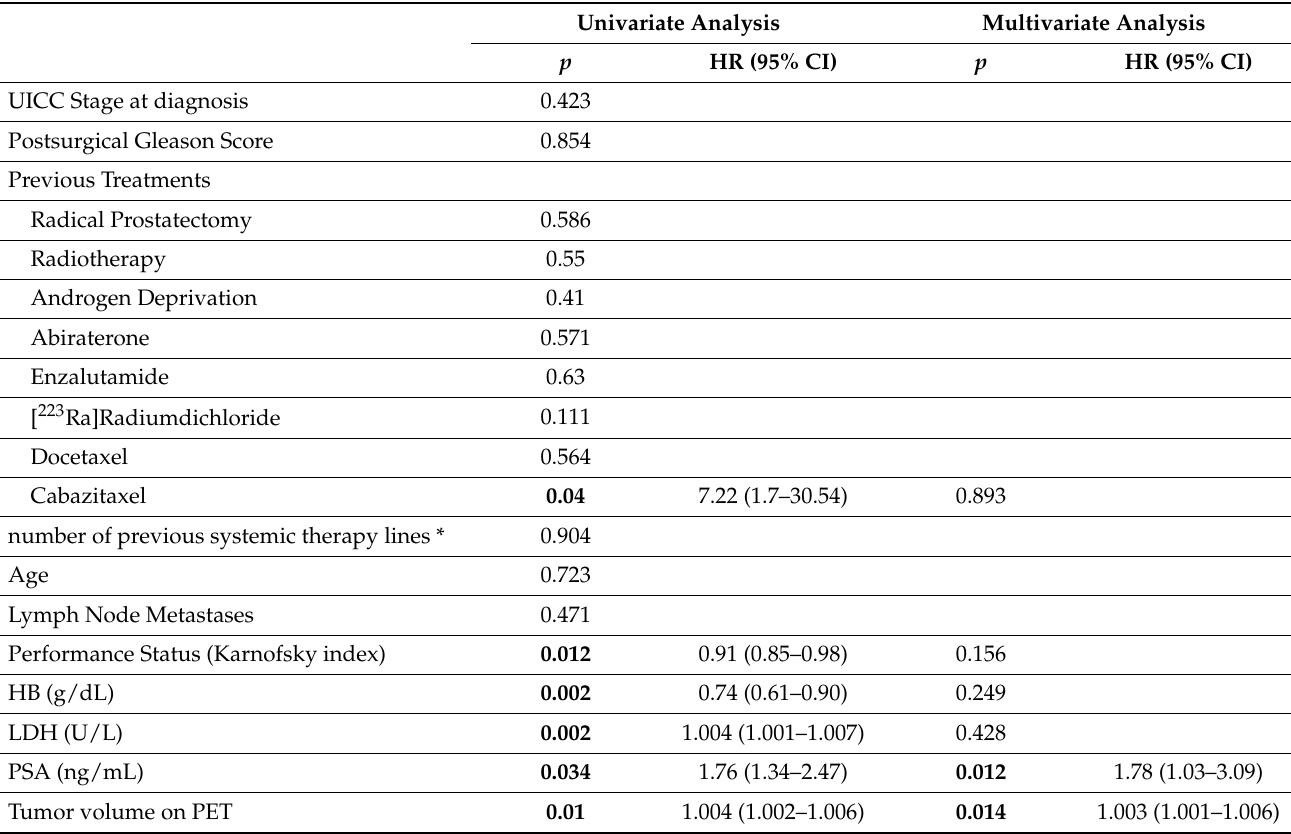
Table 1. Cox regression model of overall survival with various pretherapeutic variables (see Supplemental Table